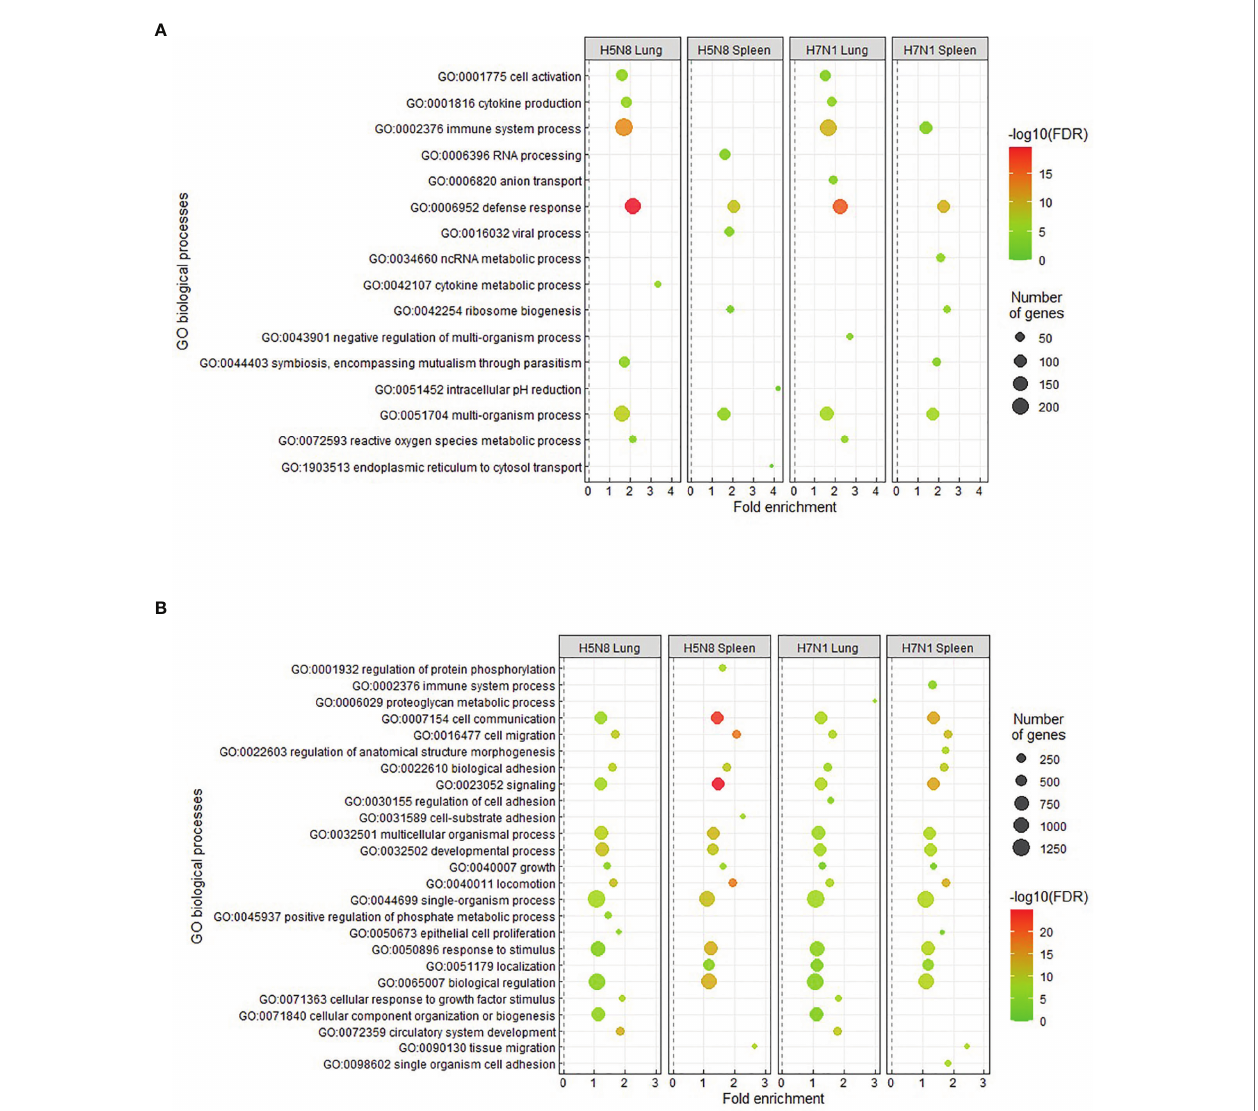
FIGURE 2 | Enriched GO terms obtained from DAVID and REVIGO for upregulated (A) or downregulated (B) DEGs in lungs and spleens collected at 3 dpi from susceptible H5N8 and H7N1 inoculated chickens. The most representative and signi fi cant biological processes are represented and are sorted by fold enrichment. The dot size indicates the number of DEGs associated with the biological process. The dot color indicates the signi fi cance of the enrichment [-log10 (FDR-corrected